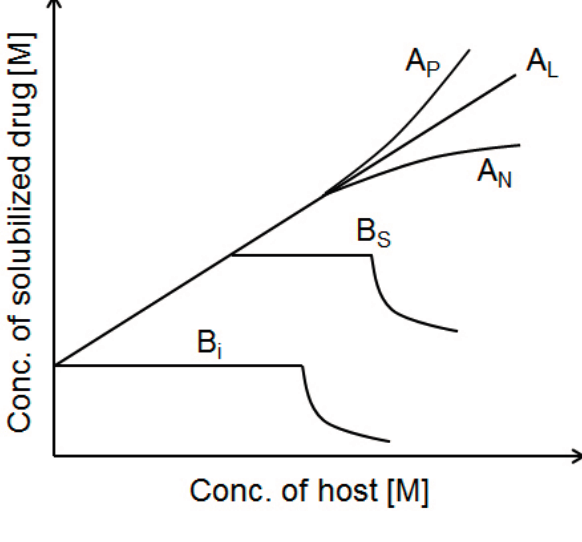
Figure 2. Phase solubility